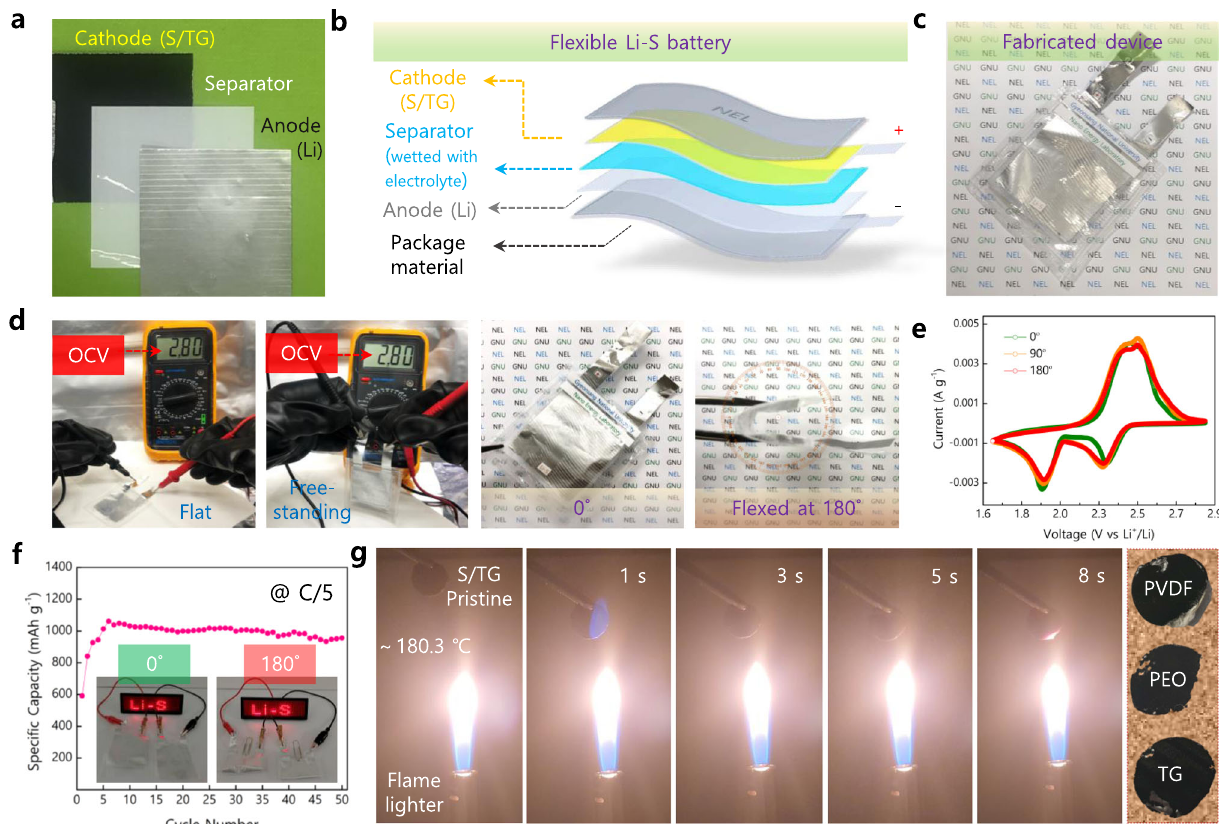
Fig. 7 Fabrication and performance of fl exible Li-S (FLS) battery. a Digital photograph of the inner con fi guration of Li-S full cell. b Schematic illustration of device fabrication. c Digital photograph of assembled FLS device. d Photograph displaying open-circuit voltage (OCV) of FLS device under fl at, free- standing, and bending angles. e Cyclability of FLS device shown through CV tests performed at 0.5 mV s − 1 in fl at (0°) and fl exing angles (90° and 180°). f Cycling performance at a current rate of C/5, inset photograph depicts the illumination of several light-emitting diodes powered by FLS device. g Flame- retardant ability of S/TG electrodes at various exposure times and the recovered electrodes after the fl ame